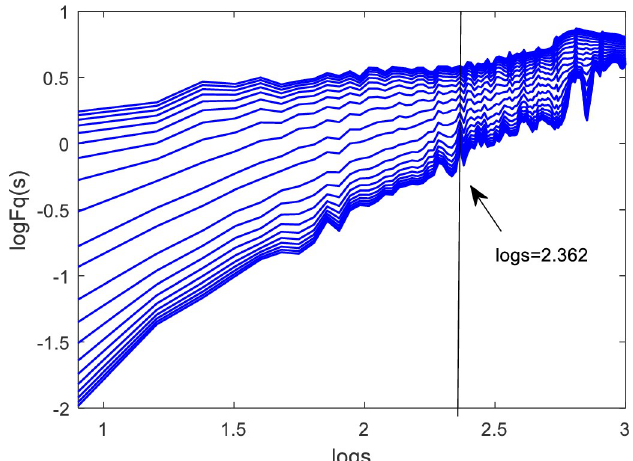
Fig 4. Logarithmic chart of the q -order wave function F q (s) and time scale s of SHIBOR and SHSML.